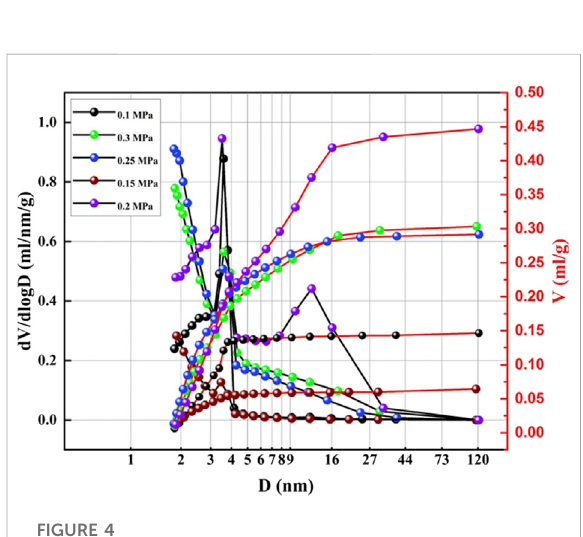
FIGURE 4 BJH(desorption)porevolumeandporesizelogarithmcurves of the as-obtained honeycomb silica gel using water glass as the starting material at different CO 2